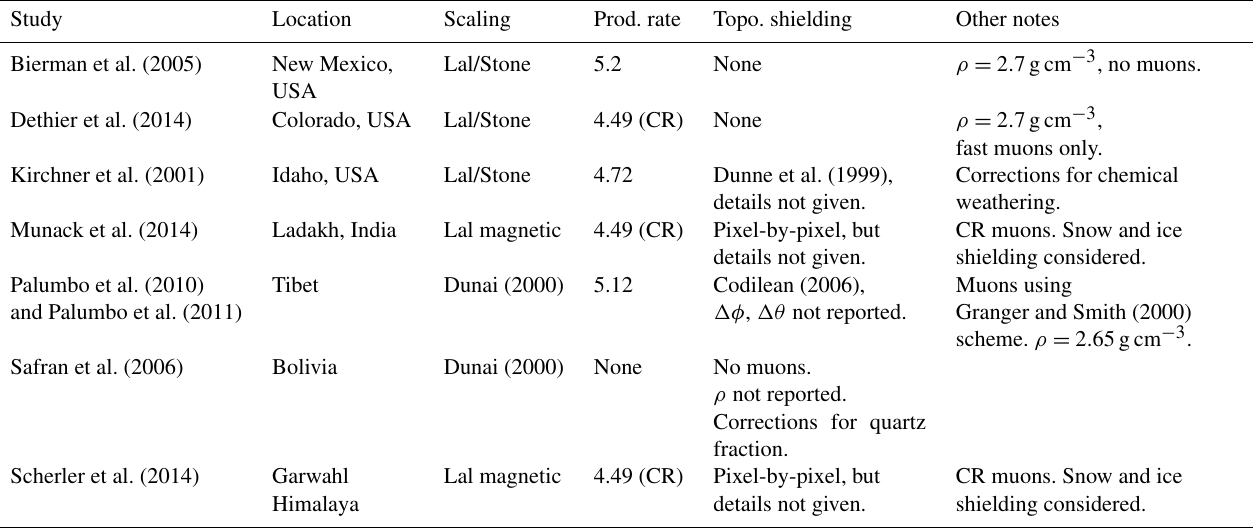
Table 3. Data sets used for method comparisons. 10 Be production rate (Prod rate) is given for sea level, high latitude and in units of atomsg − 1 yr − 1 . “CR” or “CR muons” refers to the spallation or muon calculation methods and production rates used in CRONUS-2.2 (Balco et al., 2008). The scaling values, production rates, topographic shielding and notes reported in this table are for the original studies: CAIRN uses the same settings (see Table 2) for its calculations regardless of site